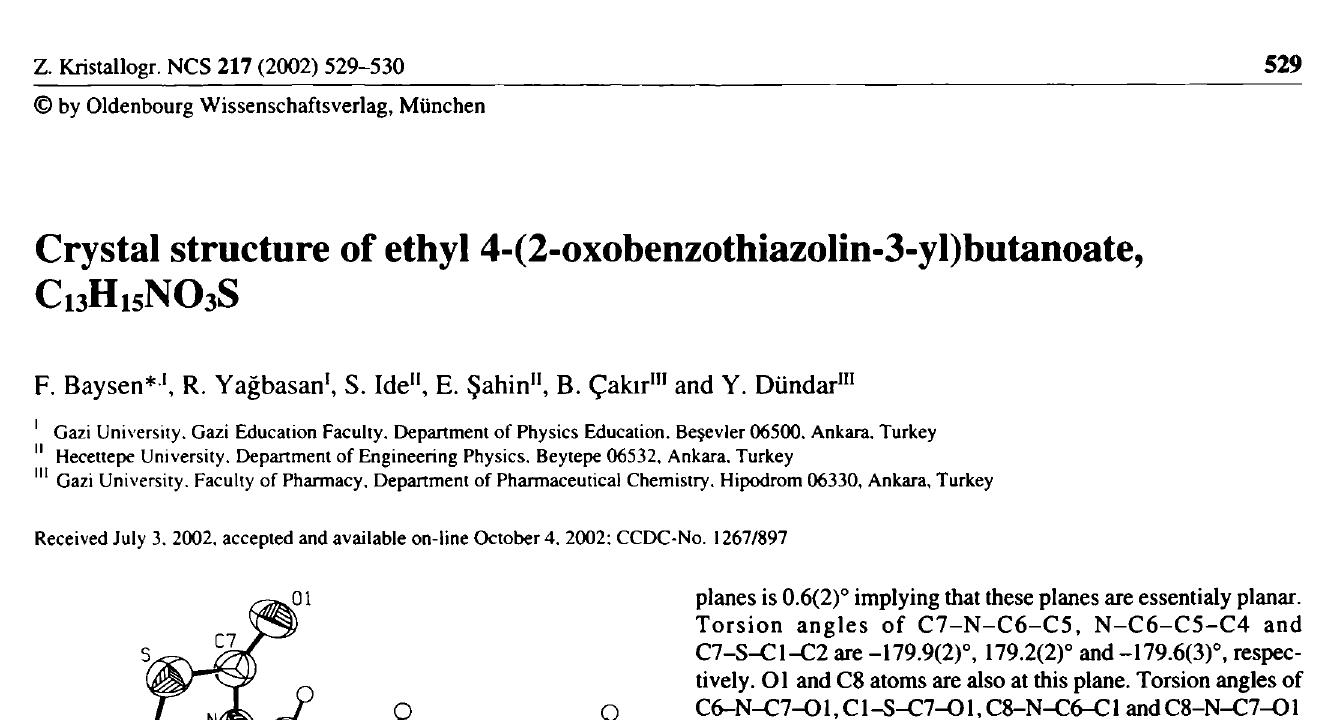
Table 1. Data collection and handling.